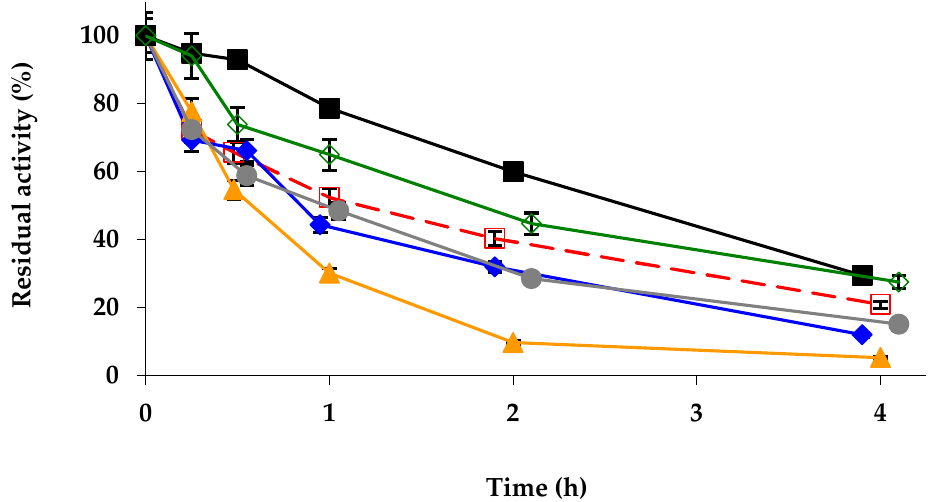
Figure 5. Inactivation courses of different octyl-CALB biocatalysts in 10 mM Tris-HCl buffer at pH 7.0 and 75 ◦ C. Other specifications are described in Methods. Unmodified octyl-TLL (empty squares and dashed and red line); octyl-TLL modified with 1% glutaraldehyde (solid rhombus and solid blue line); amination using 2 M ethylenediamine (solid triangles and solid orange line); 1 mM picrylsulfonic acid (solid circles and solid grey line); 10% polyethylenimine (solid squares and solid black line); 10% dextran sulfate (empty rhombus and solid green line).